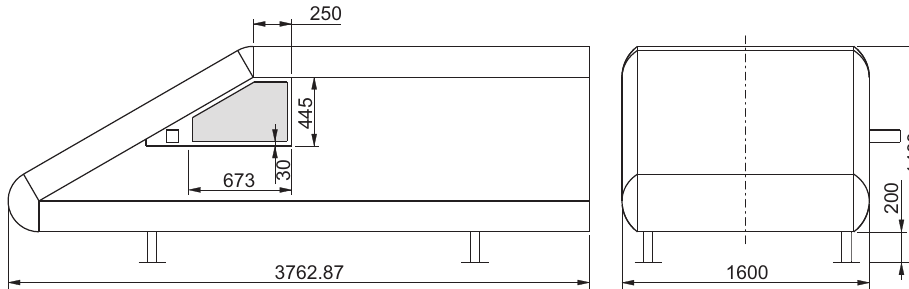
Figure 1. Schematic drawing of the dimensions of the simpli fi ed car model with units in mm.